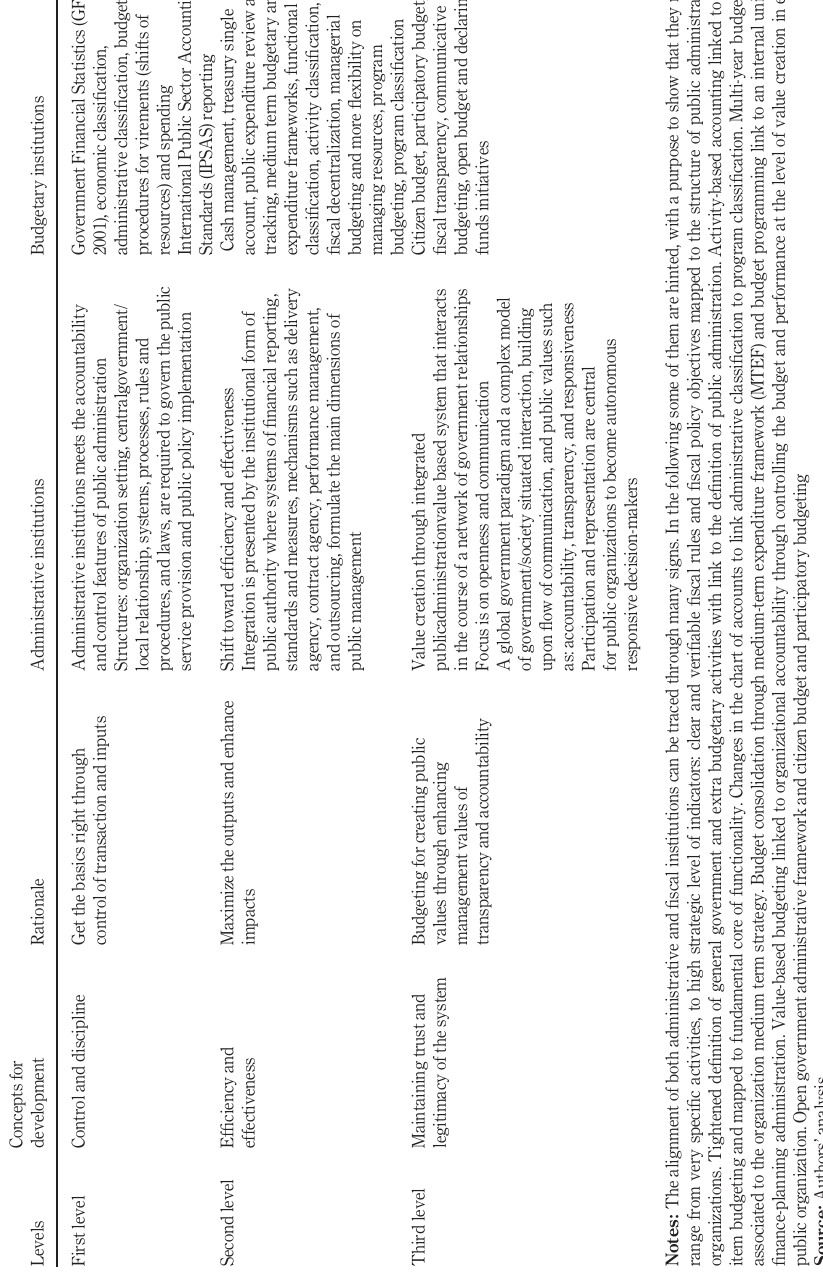
Table I. The aligned temperament of administrative and budgetary